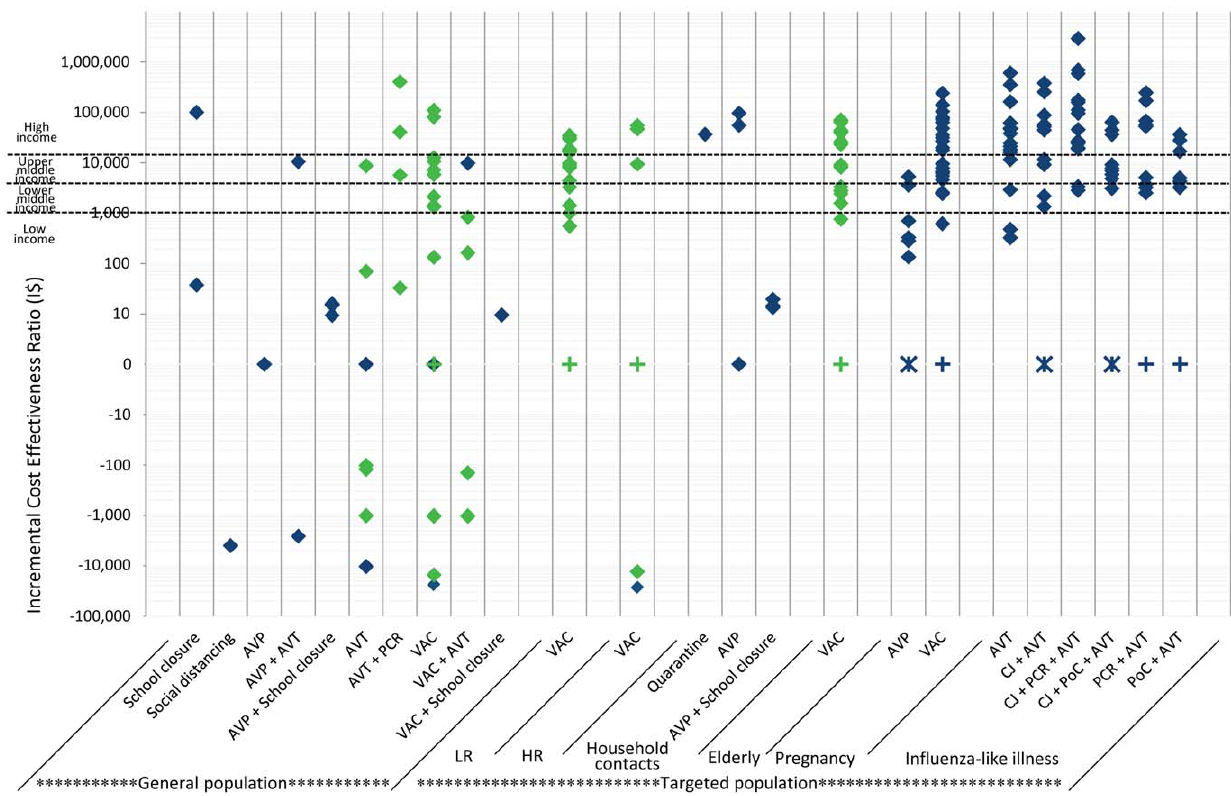
Figure 3. Incremental Cost Effectiveness Ratios (ICERs) for influenza pandemics according to type of intervention (I $ /QALY). AVP =antiviral prophylaxis; AVT =antiviral treatment; CJ =clinical judgment; PCR =polymerase chain reaction; PoC =point of care test; HR =high risk for complications; LR =low risk for complications; VAC =vaccine; Blue =results of studies conducted before the 2009 H1N1 pandemic; Green =results of studies conducted after the 2009 H1N1 pandemic; X =average incremental cost effectiveness ratio; ???=cost saving intervention, ICER was not clearly stated; w =Cost saving/less effective intervention, ICER was not clearly stated.